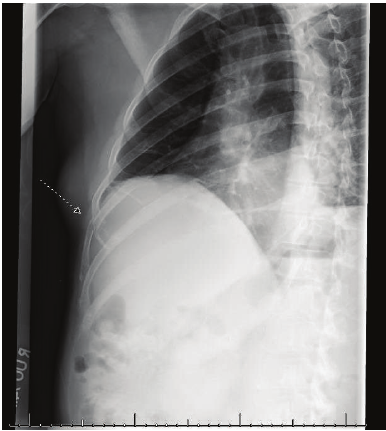
Figure 1: X-ray of the right sided ribs revealing a fracture involving the lateral aspect of the 7th rib.